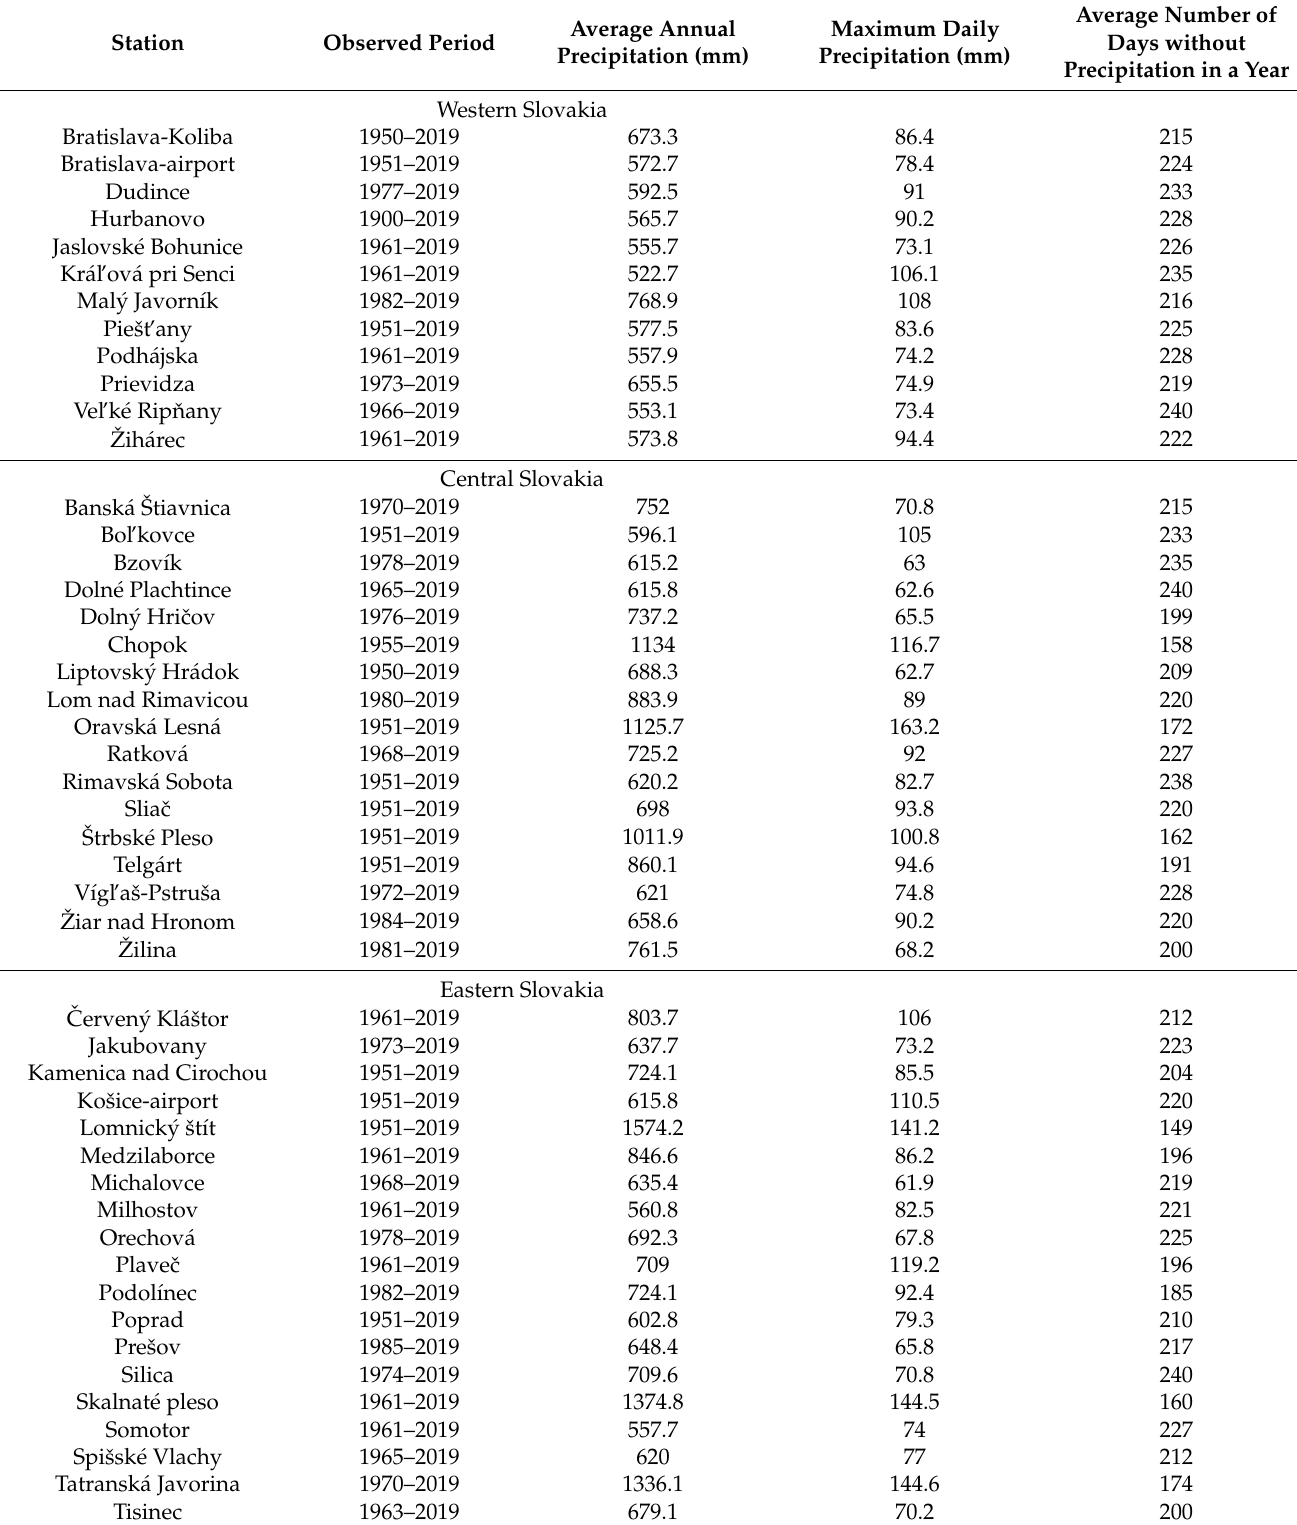
Table 2. Basic statistics of precipitation in